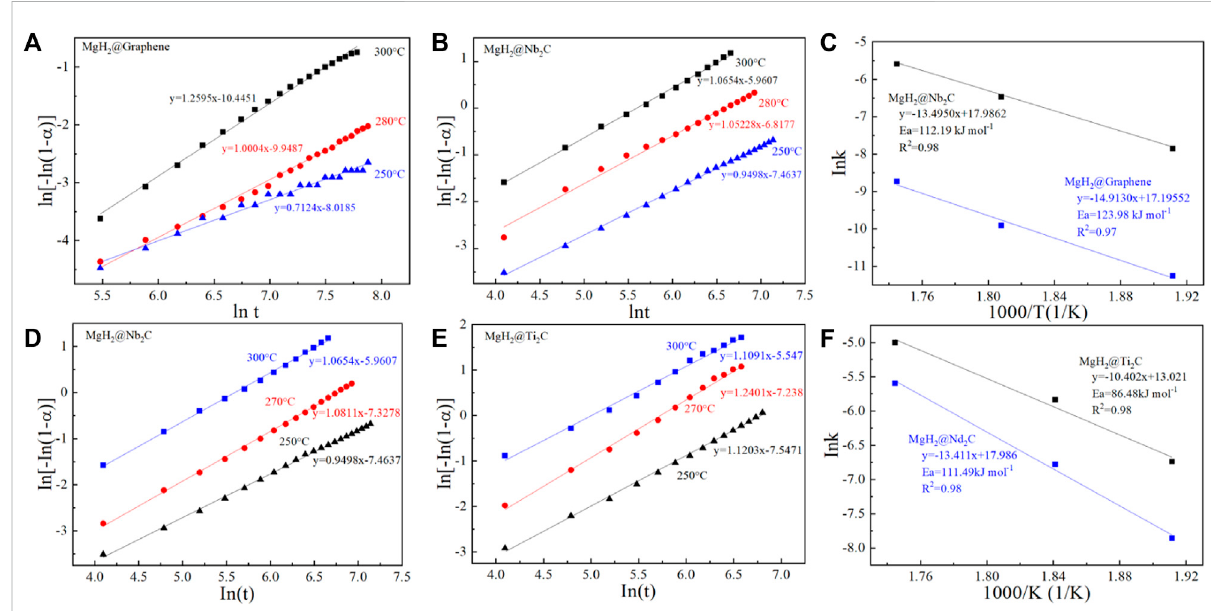
FIGURE 6 JMAKplots forthehydrogendesorptionatdifferenttemperature (A) MgH 2 @Graphene, (B) MgH 2 @Nb 2 Cand (C) correspondingArrheniusplots, JMAK plots for the hydrogen desorption at different temperature (D) MgH 2 @Nb 2 C, (E) MgH 2 @Ti 2 C, and (F) corresponding Arrhenius